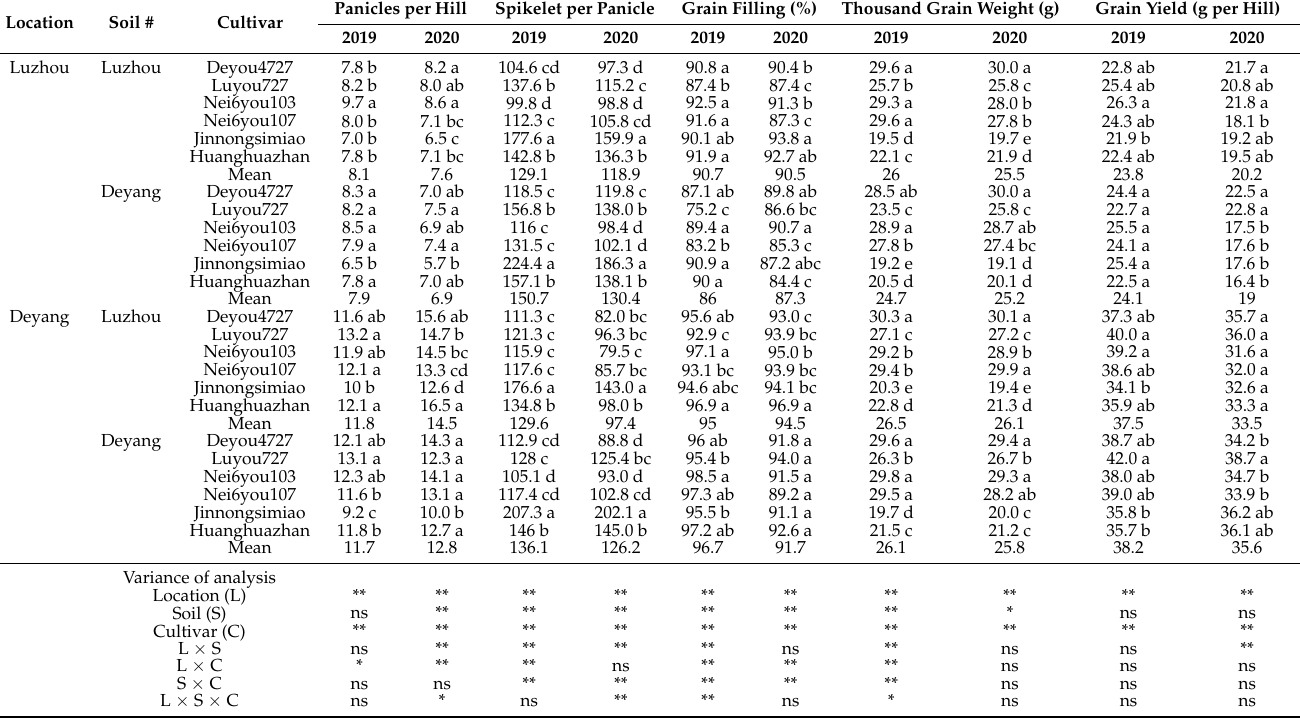
Table 7. Grain yield and yield components of six rice cultivars grown under two different ecological conditions in a pot experiment from 2019 to